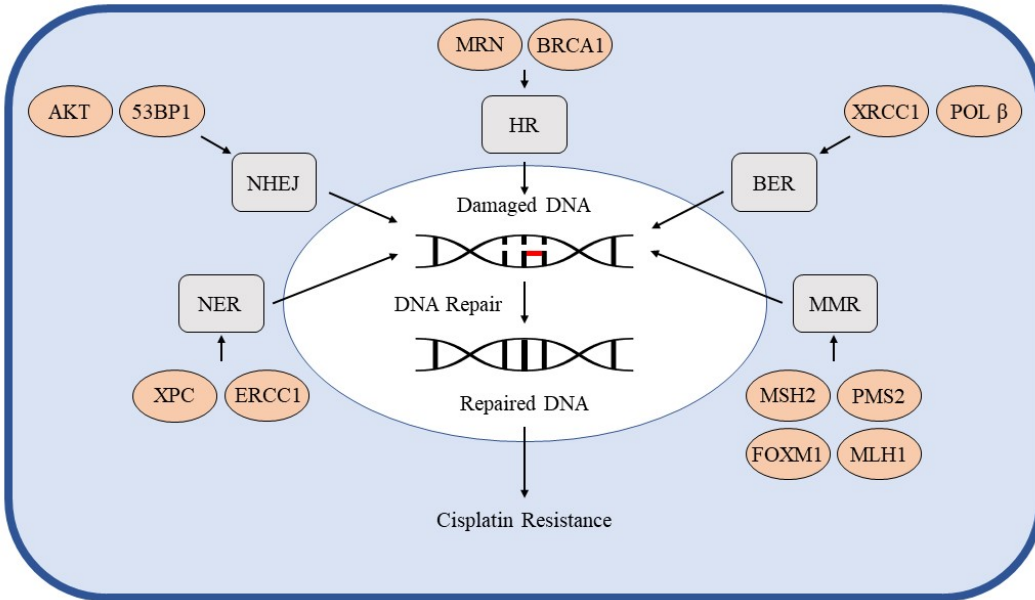
Figure 2. DNA repair pathways and cisplatin resistance. The dark blue border represents the cell membrane, with the light blue interior being the cytosol and the white oval being the nucleus. The grey rectangles represent the mechanisms of DNA damage repair (DDR). The DDR pathways act on damaged DNA to repair the molecule and restore genome integrity. DNA with an intrastrand crosslink is represented in the nucleus by the DNA molecule with a red bar linking two adjacent bases. The repaired DNA lacks the red bar representing the intrastrand crosslink. Each orange oval represents a protein involved in DDR that has been implicated in cisplatin resistance. Arrows point from groups of these DDR proteins to their associated DDR pathway. Enhanced DDR activity in cancer allows for restoration of cisplatin-induced DNA damage and resistance to treatment.